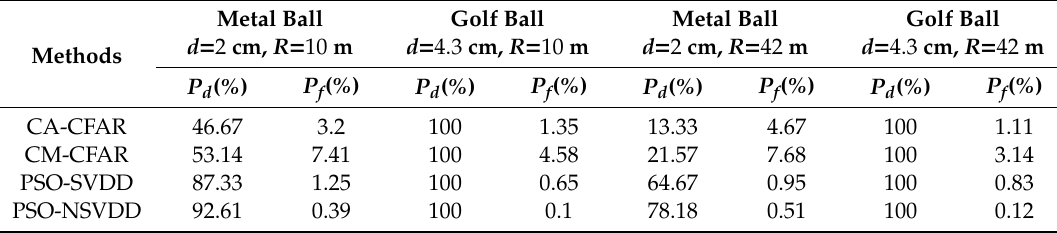
Table 1. The detection results using di ff erent